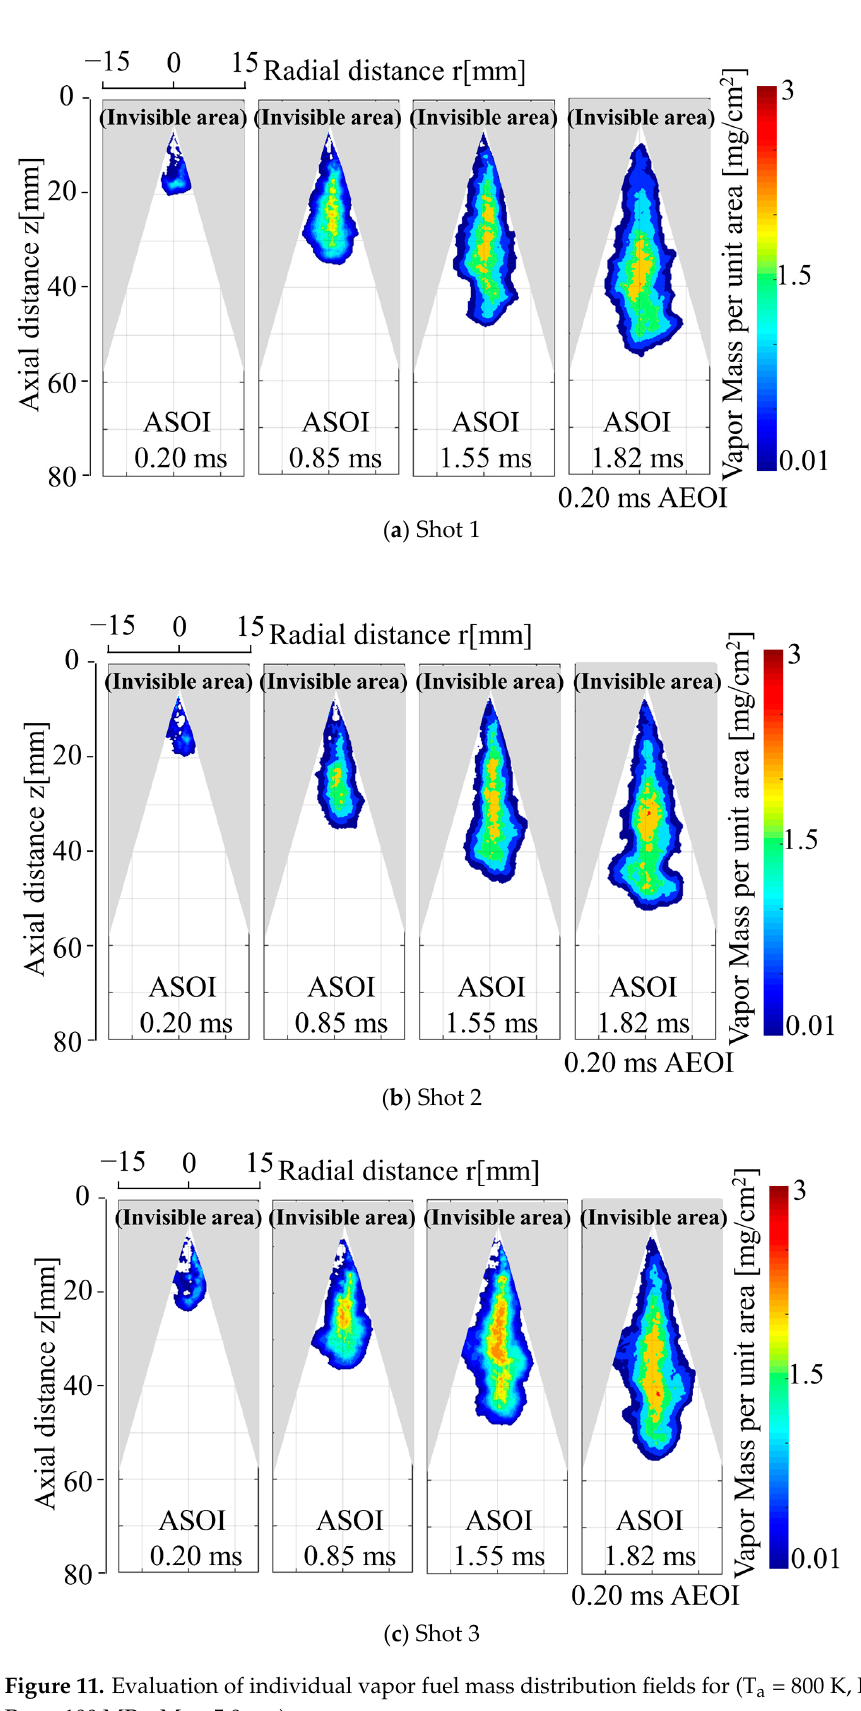
Figure 11. Evaluation of individual vapor fuel mass distribution fields for (T a = 800 K, P a = 4.8 MPa, P inj = 100 MPa, M f = 5.0 mg).